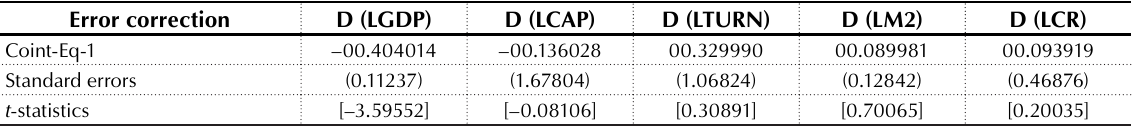
Table 5B. Target model estimation